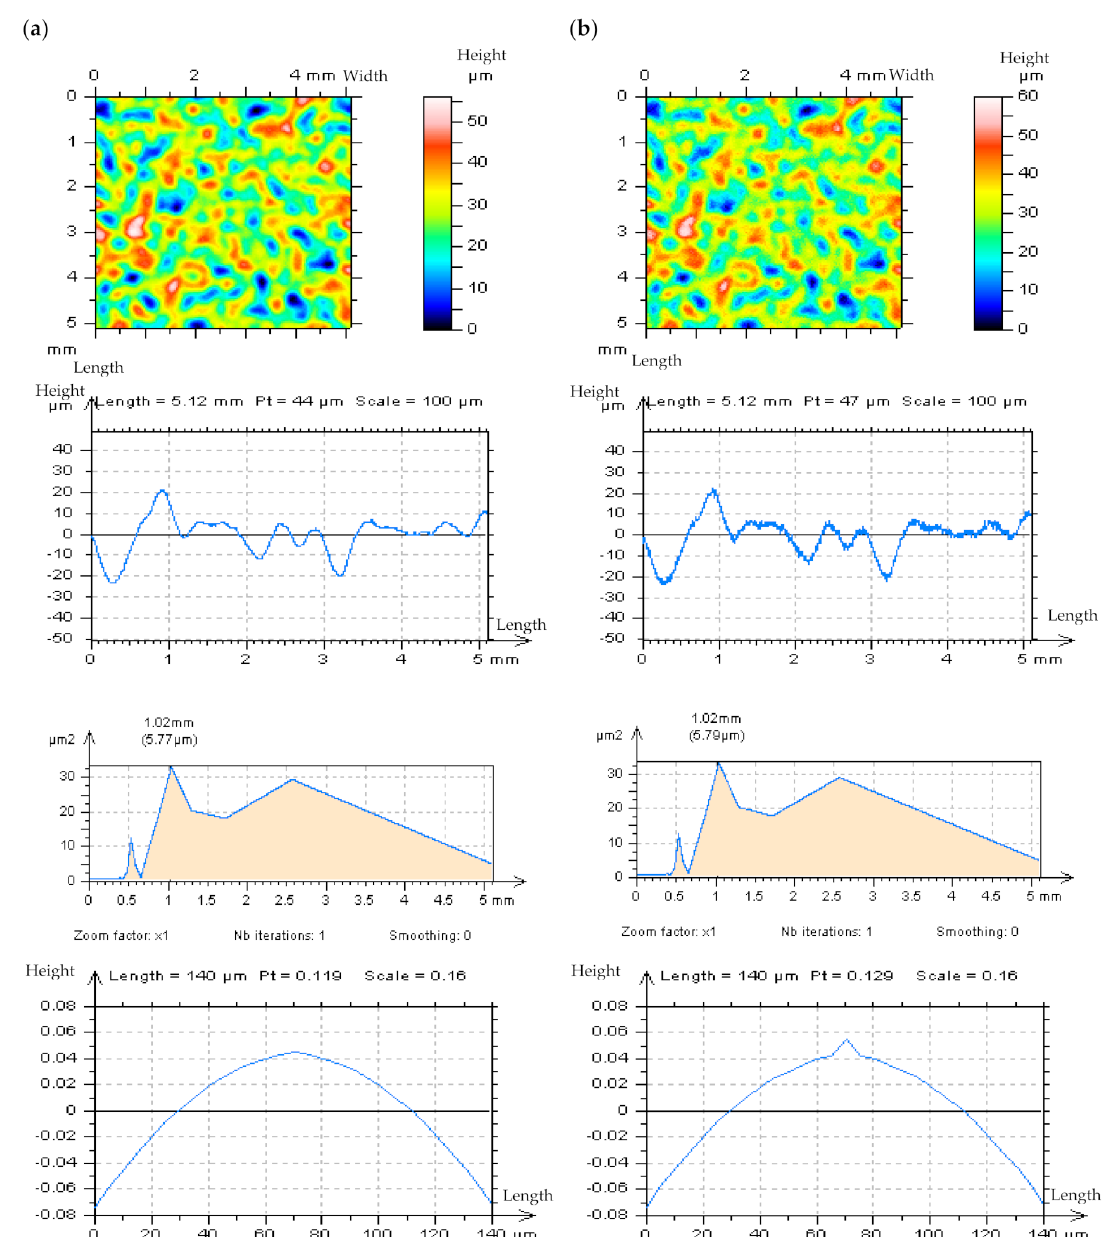
Figure 8. The isometric views of ceramic surface topography, their extracted profiles with PSDs and ACFs, respectively, measured at the speed of 0.5 mm/s ( a ) and after adding a high–frequency noise with Sq equal to 20% of the Sq of measured detail ( b